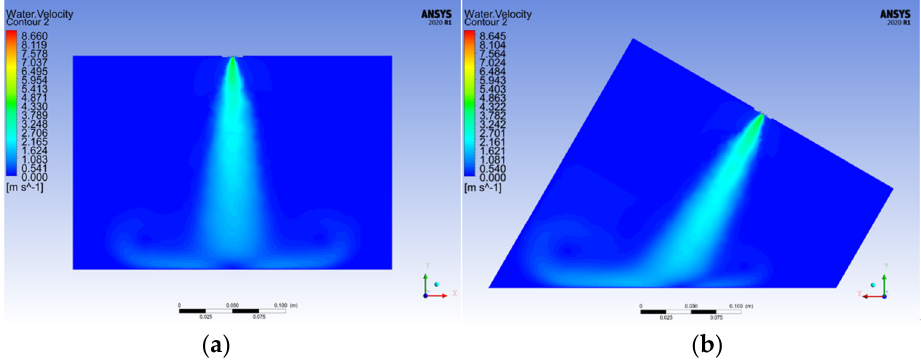
Figure 3. Velocity distribution of the vertical spraying and dip spraying fog fields.